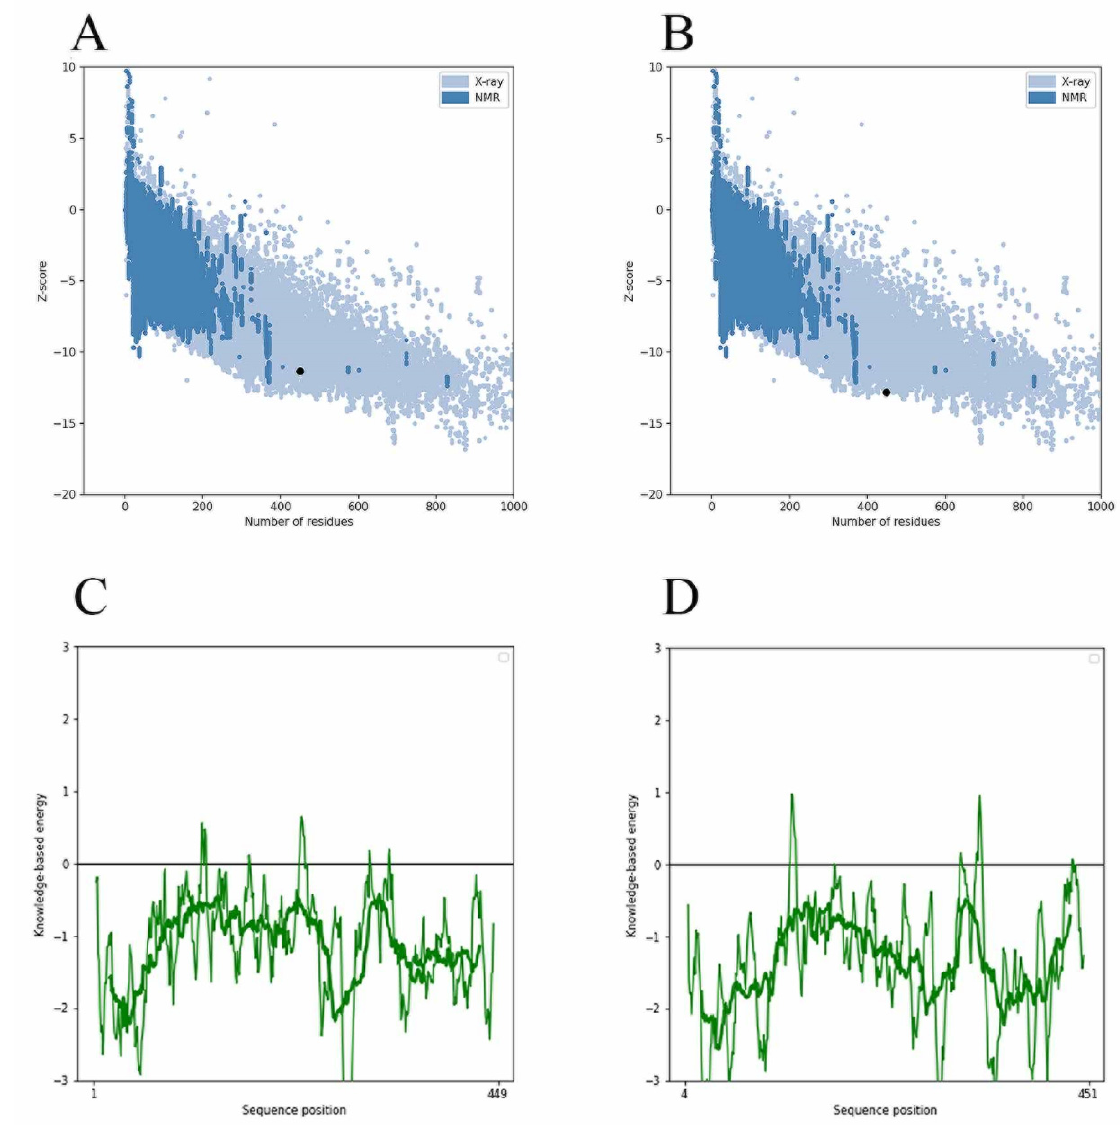
Figure 2. Validation of MurD Ligase model using PROSA. ( A ) MurD enzyme protein overall model quality. ( B ) 3lk7 protein overall model quality; black spots show the similarity of the model with X-ray and NMR structures, X-ray crystallography (light blue region) or NMR spectroscopy (dark blue region). ( C ) MurD enzyme protein residue energy diagram. ( D ) 3lk7 protein residue energy diagram.